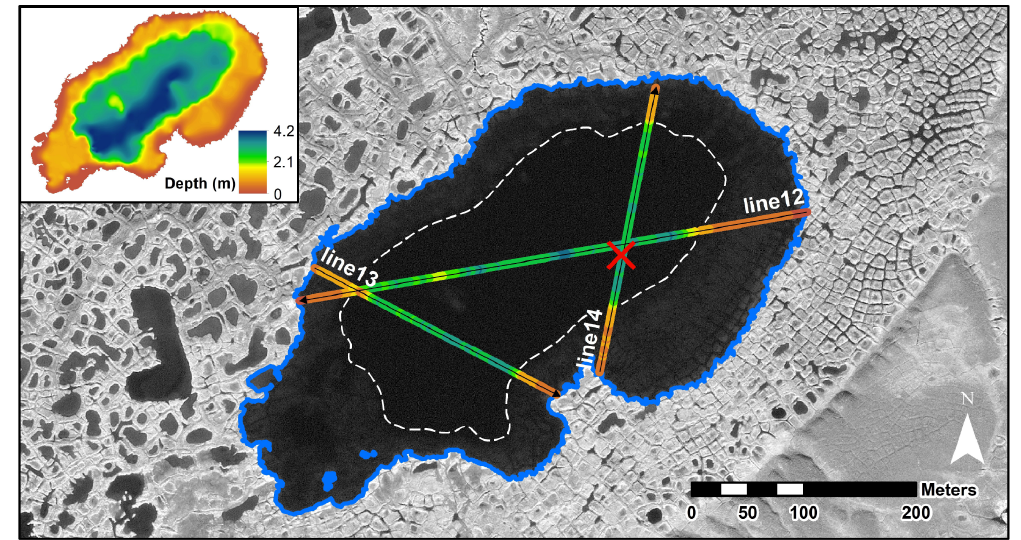
Figure 2. Bathymetry and GPR survey lines conducted on Gull Lake. Sediment coring location is shown (red “x”). GPR line cross sections (12, 13, 14) are shown in Fig. 3. The lake limit is delineated by a blue polygon. The central basin is deeper and surrounded by a shallow platform where degraded ice-wedge polygons are visible. The boundary between the central basin and the shallow platform is shown by the dashed white line. Satellite image: GeoEye-1, 18 July